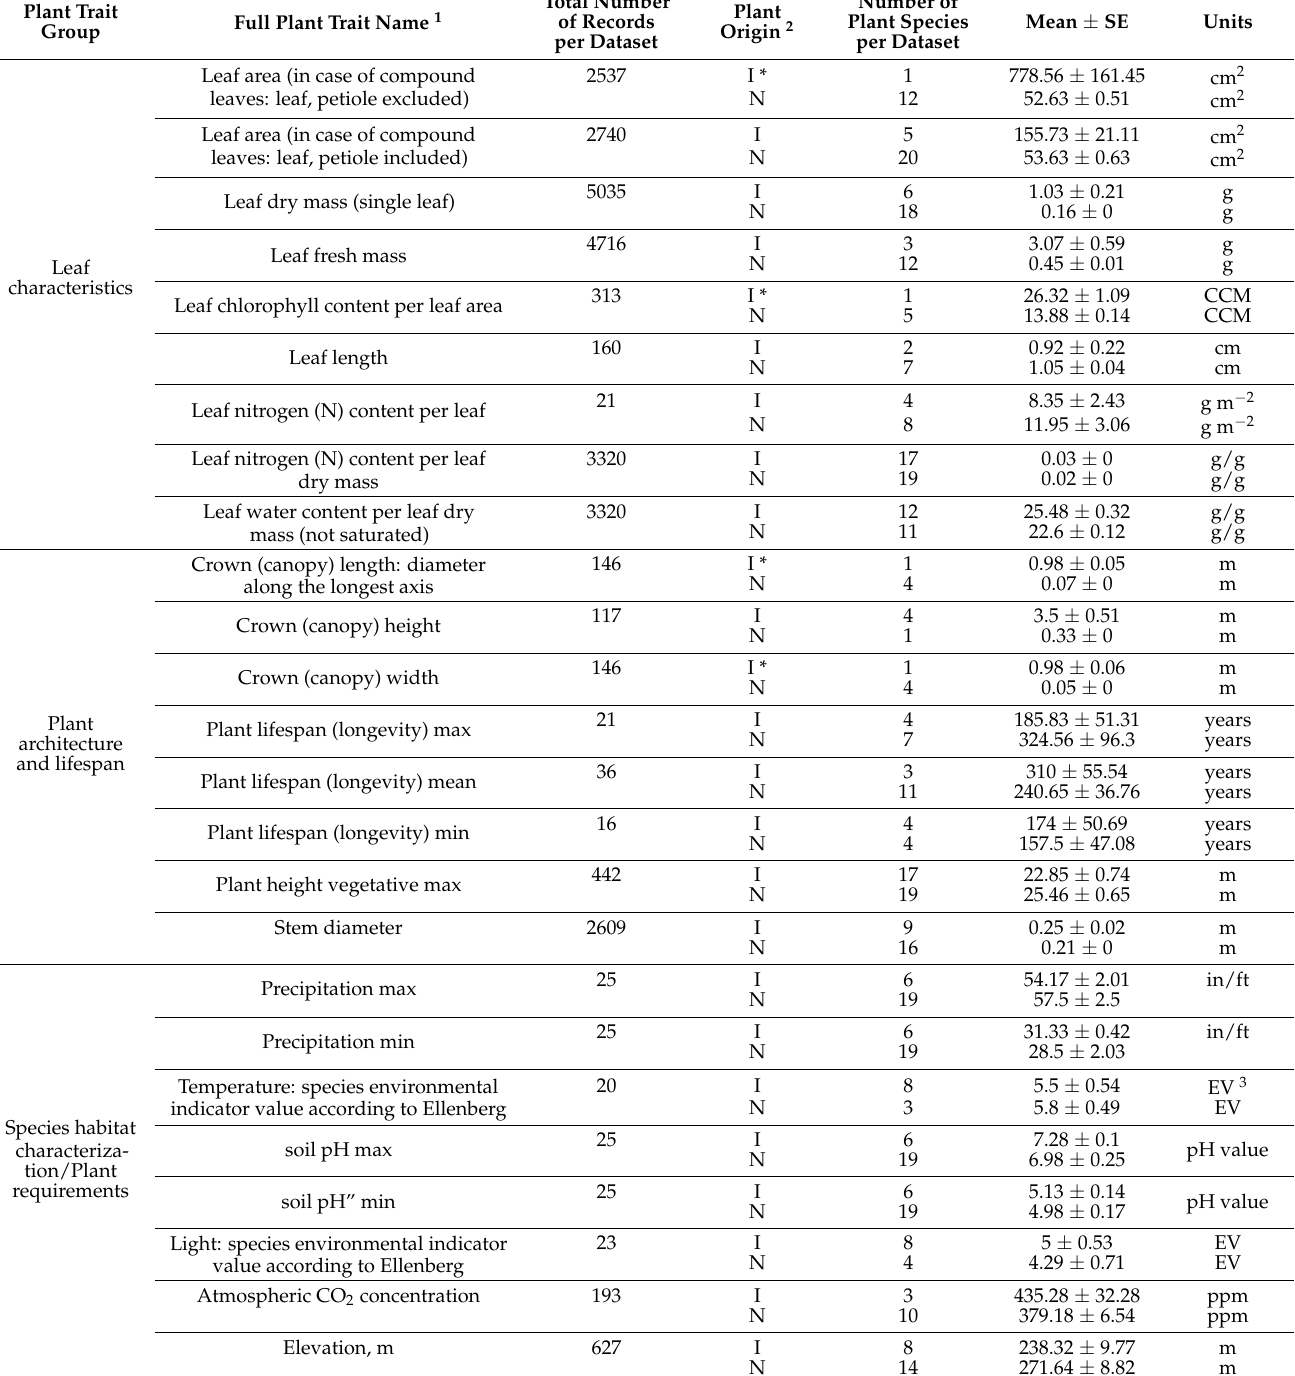
Table 3. Mean values and standard errors (Mean ± SE) for each plant trait of native and introduced host plants of Lycorma delicatula